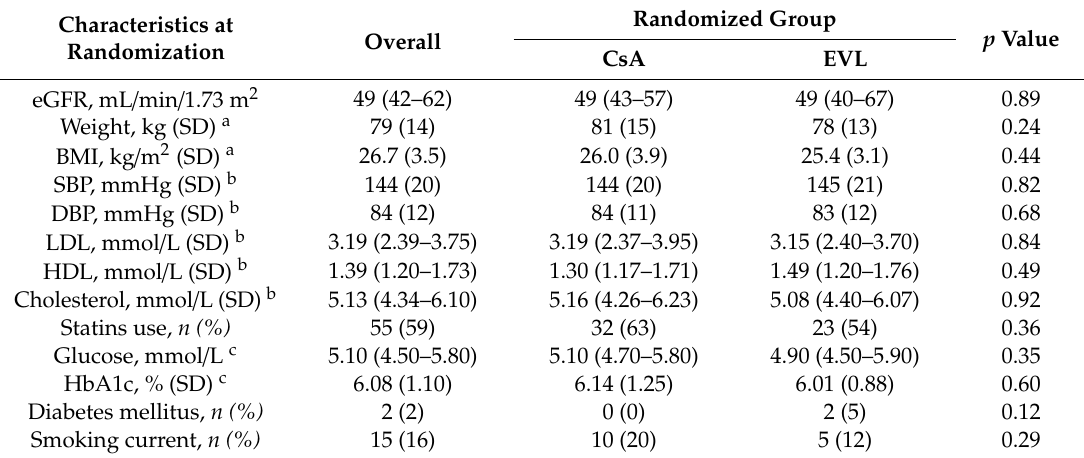
Table 2. Characteristics at randomization of study population, overall KTRs, and randomization groups. Characteristics